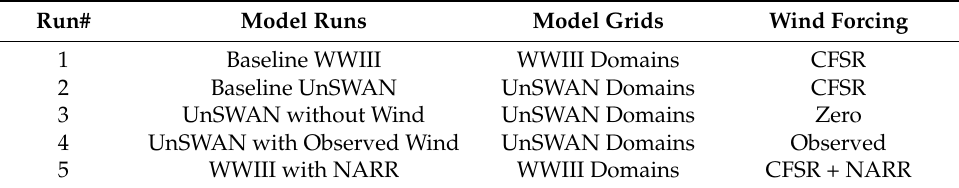
Table 2. Designed model